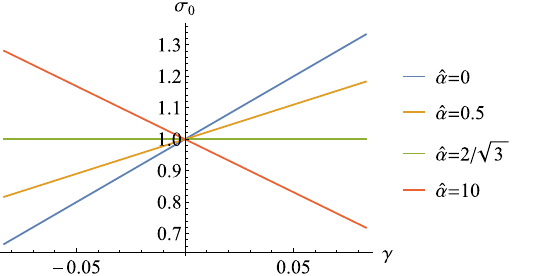
coupling parameter γ . (For interpretation of the references to color in this figure, the reader is referred to the web version of this paper)